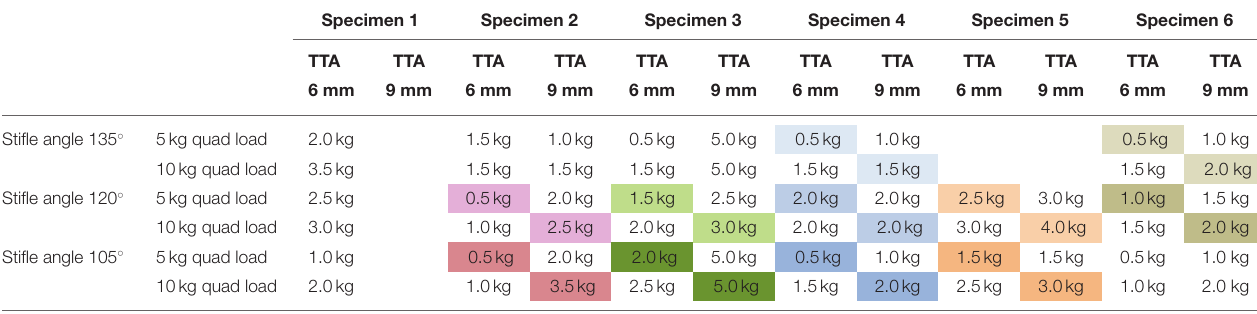
Color added for emphasis.